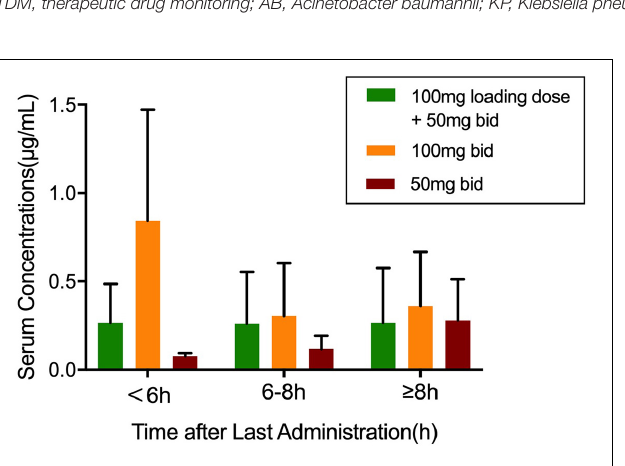
FIGURE 1 | The plasma concentrations of tigecycline in 67 patients. Values were sorted into three groups according to the medication regimen. Data was shown as mean ± SD.